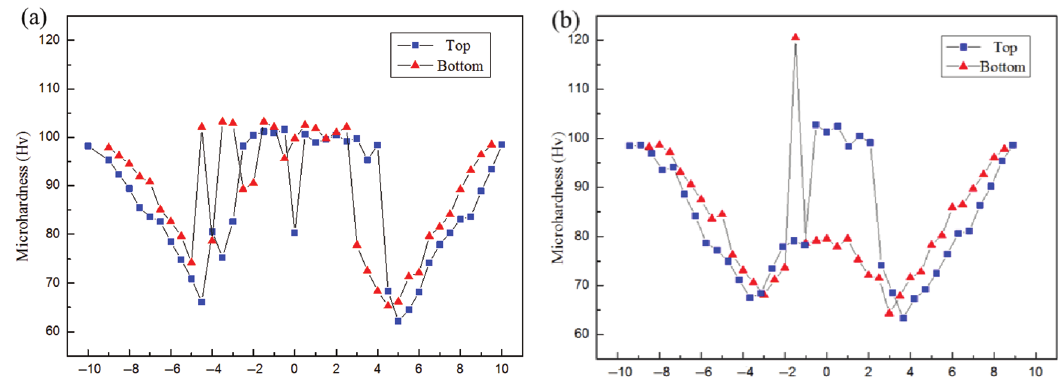
Figure 12: Microhardness of joints under different welding speeds: (a) 50 mm/min and (b) 200 mm/min.